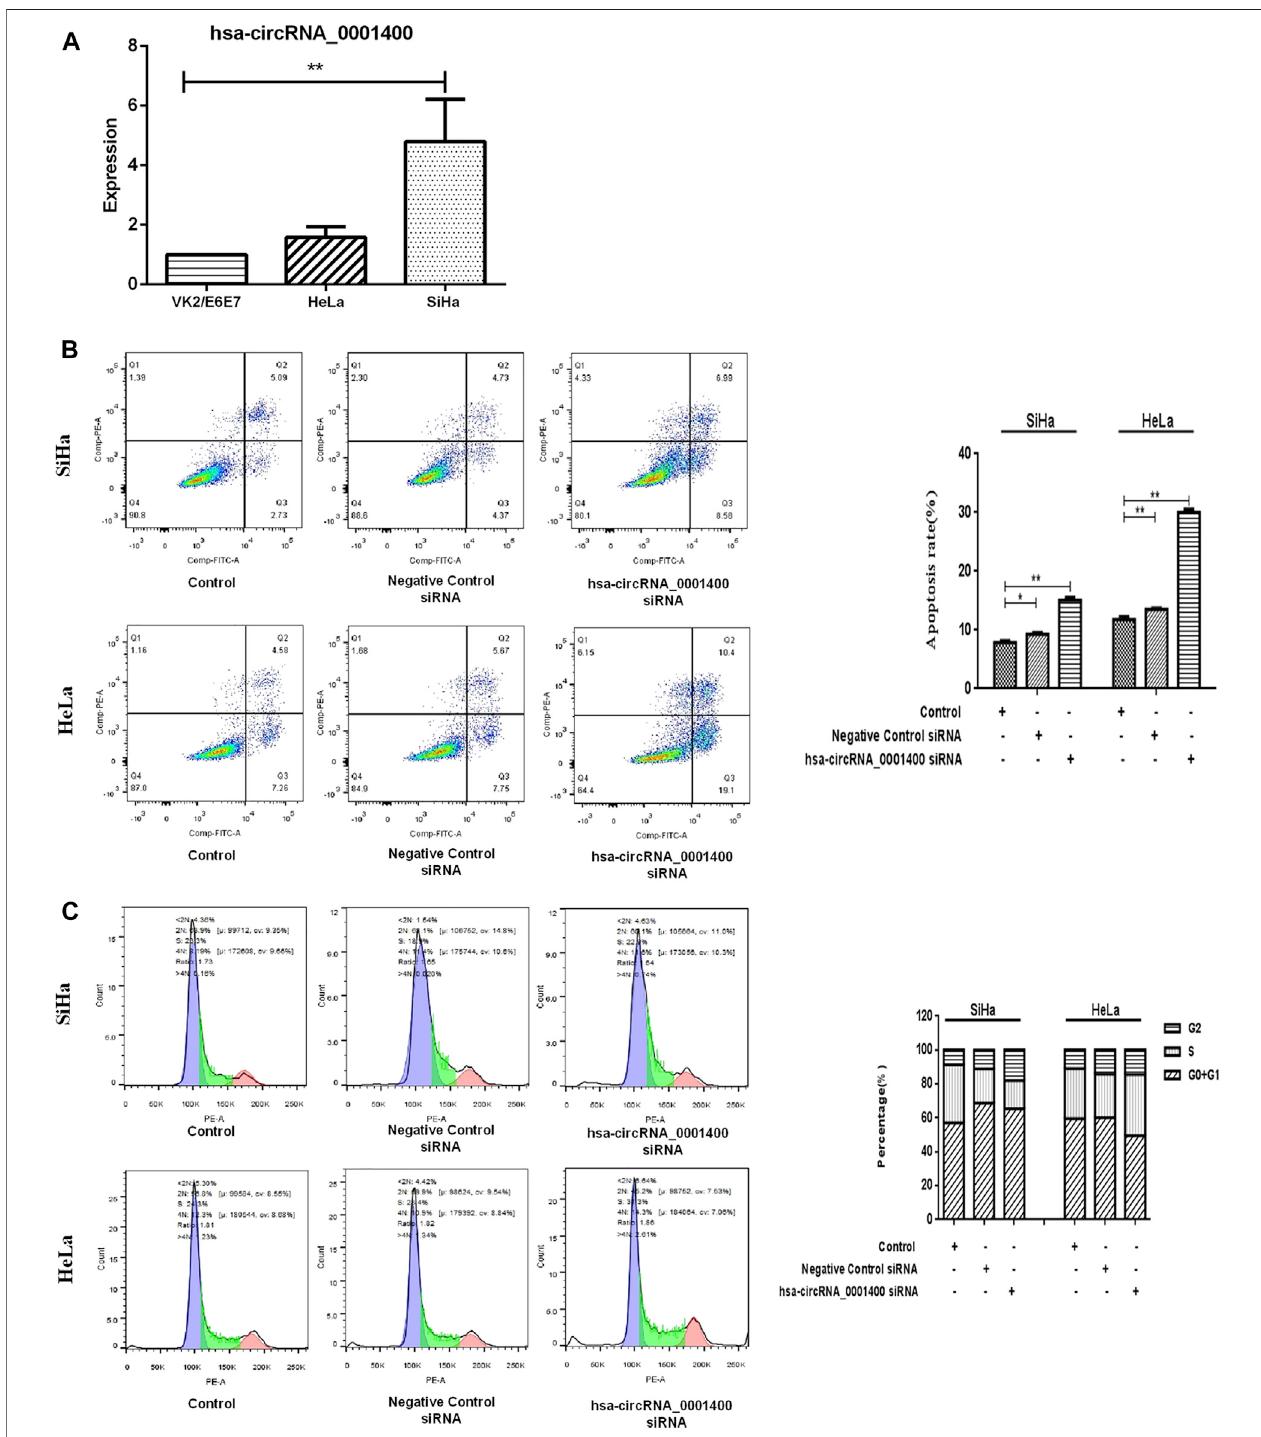
FIGURE 2 | Hsa-circRNA_0001400_siRNA promotes the apoptosis of cervical cancer cells and causes G1-phase arrest of the cell cycle. (A) hsa_circRNA_0001400inhumanvaginalepithelial,cervicalcancerSiHa,andHeLacelllines. (B) Theeffectofhsa_circRNA_0001400_siRNAontheapoptosisofcervical cancercells. (C) Theeffectofhsa_circRNA_0001400_siRNAonthecellcycleofcervicalcancercells. (D) Theeffectofhsa_circRNA_0001400_siRNAoncervicalcancer colonyformation. (E) Theeffectsofhsa_circRNA_0001400_siRNAonAkt,Phospho-Akt(Ser473),PI3K,andPhospho-PI3Kinasep85(Tyr458)proteinexpression in cervical cancer cells. Data are expressed as mean ± standard deviation, n (cid:2) 3, * p < 0.05 and * * p < 0.01 vs. control group.